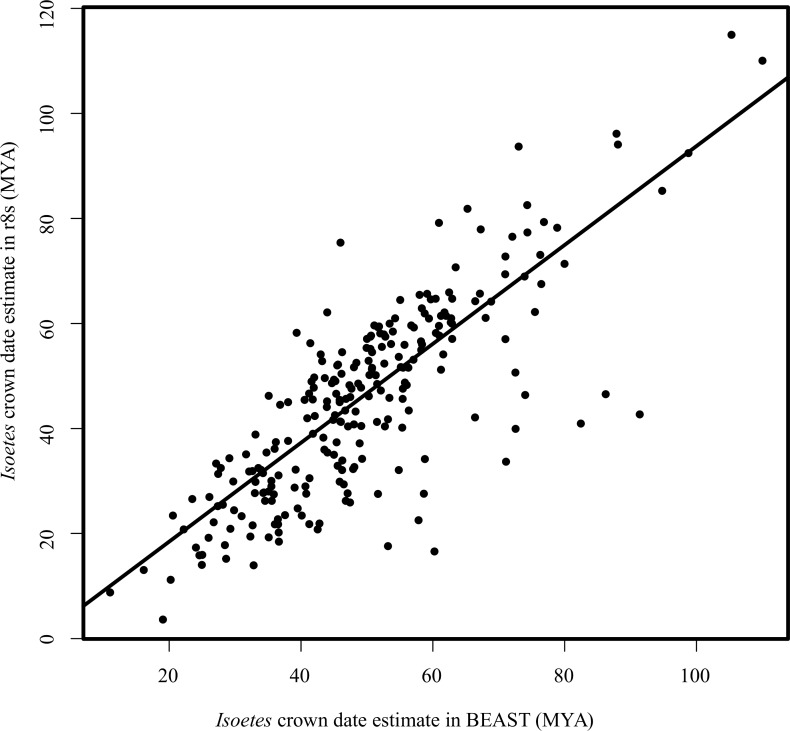
r8s versus BEAST Isoetes crown estimates for individual nuclear genes.The scatterplot shows the estimates of the Isoetes crown date in r8s and BEAST for each individual nuclear gene. Line represents output of linear model using lm() function in R v3.5.2.